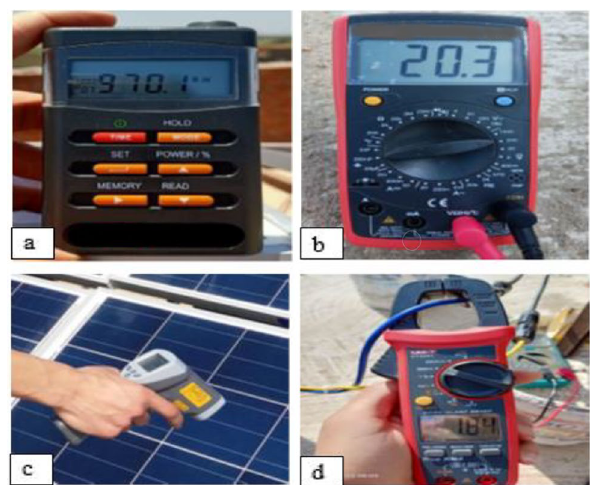
Figure 3. Measurement